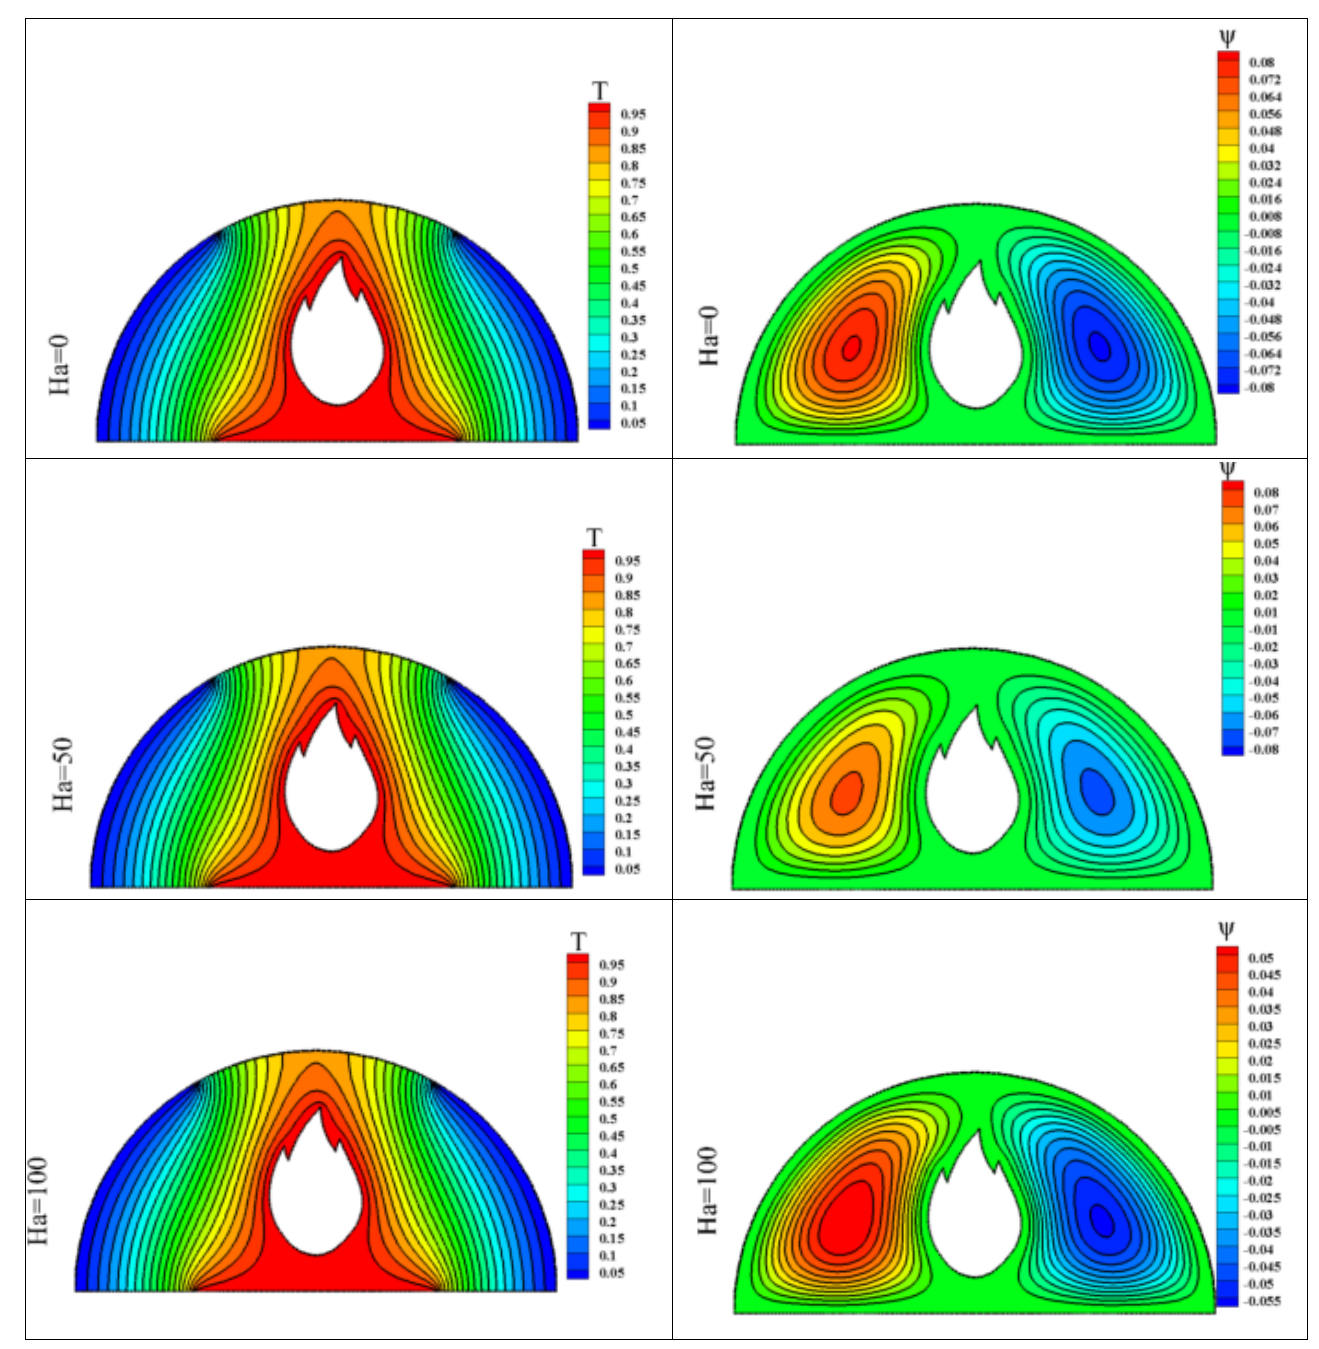
Figure 11. Streamlines ( right ) and isotherms ( left ) inside the enclosure for various values of Ha at ( φ = 0.02, L = 0.2, Rd = 0.5, Da = 10 − 4 and Ra = 10 5 ).